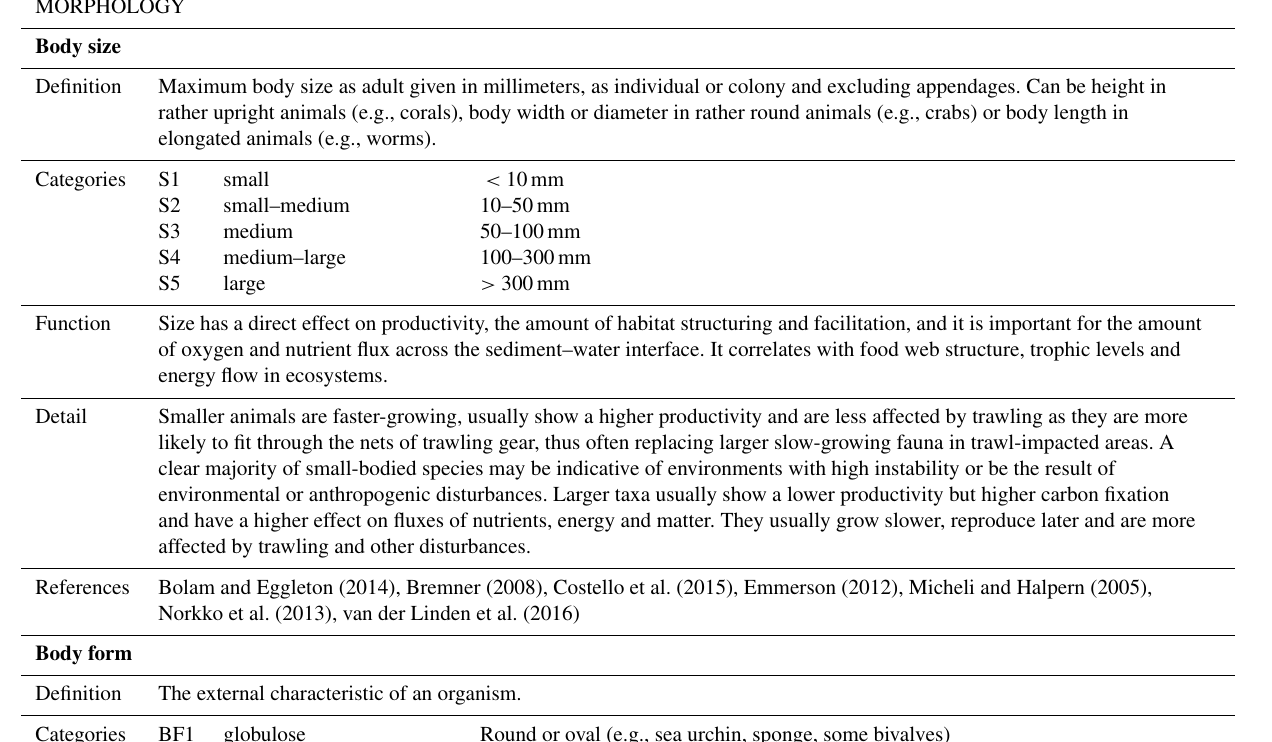
Table 3. Detailed information on the 19 biological traits currently included in the Arctic Traits Database, clustered into morphology traits (5), life history traits (3) and behavioral traits (11). For every trait and its categories, the definition as used in the Arctic Traits Database is given. Abbreviations of each category are given (e.g., S1, S2) as these are used in files downloaded from the website. The relation of the respective trait to benthic ecosystem functions or responses (i.e., its role as effect or response trait) is given via specific examples, and underlying literature sources are